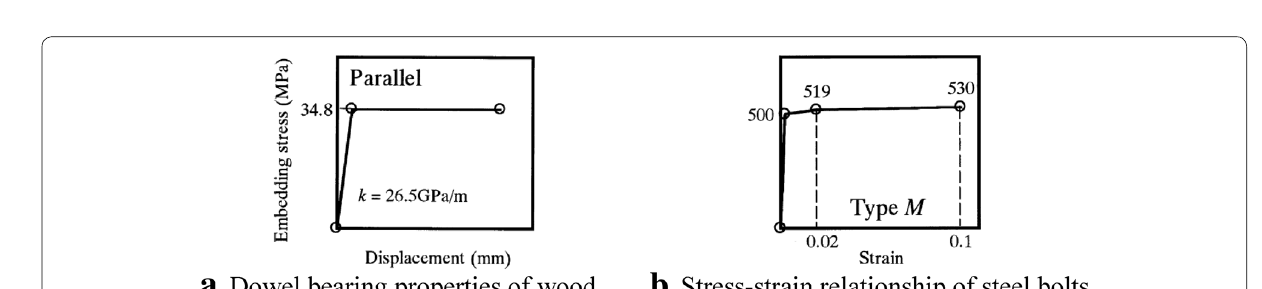
4 EI P = β = , k s 4 � k s (cid:29) (cid:30) (cid:31) where k s and EI are determined by the material prop- erties and geometries of the timber and the bolt. β is